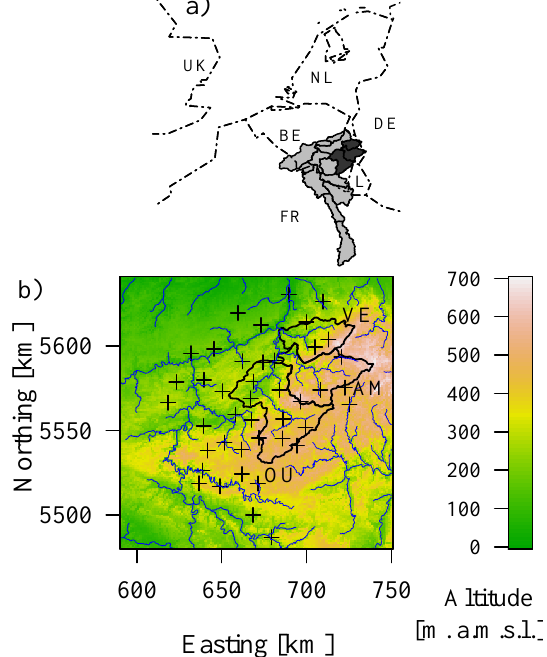
Fig. 1. (a) The Meuse River basin upstream of Borgharen ( ∼ 21000km 2 ), the entrance point into the Netherlands, and its 15 sub-catchments (grey polygons) including the Upper Ourthe, Ambl`eve and Vesdre sub-catchments (black polygons). (b) Topo- graphic map of the Belgian Ardennes including the Upper Ourthe (OU), Ambl`eve (AM) and Vesdre (VE) sub-catchments, the chan- nel network (blue lines), and rain gauges (plusses). Projection is in the Universal Transverse Mercator (UTM) 31N coordinate system. After Hazenberg et al. (2011).